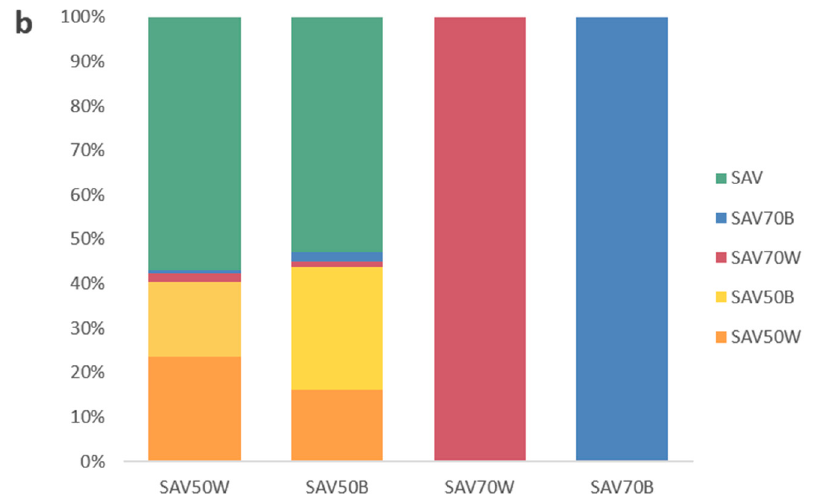
Figure 7. Percentage of the measurements that have been assigned to a predicted group after the use of the adaptors on ( a ) MAV and ( b ) SAV. Samples were colored according to the used adaptor. MAV, medium area view; SAV, small area view; 50B, 50% reduction with black adaptor; 50W, 50% reduction with white adaptor; 70B, 70% reduction with black adaptor; 70W, 70% reduction with white adaptor.